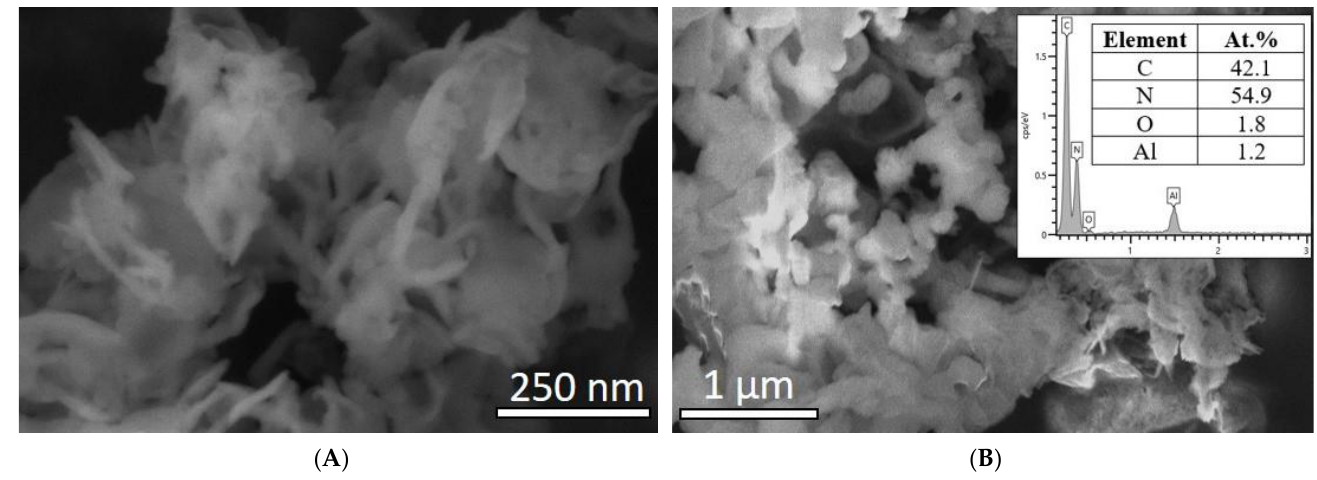
Figure 6. ( A ) SEM image of g-C 3 N 4 powder and ( B ) SEM image of immobilised g -C 3 N 4 on alumina surface along with EDXS conducted over the